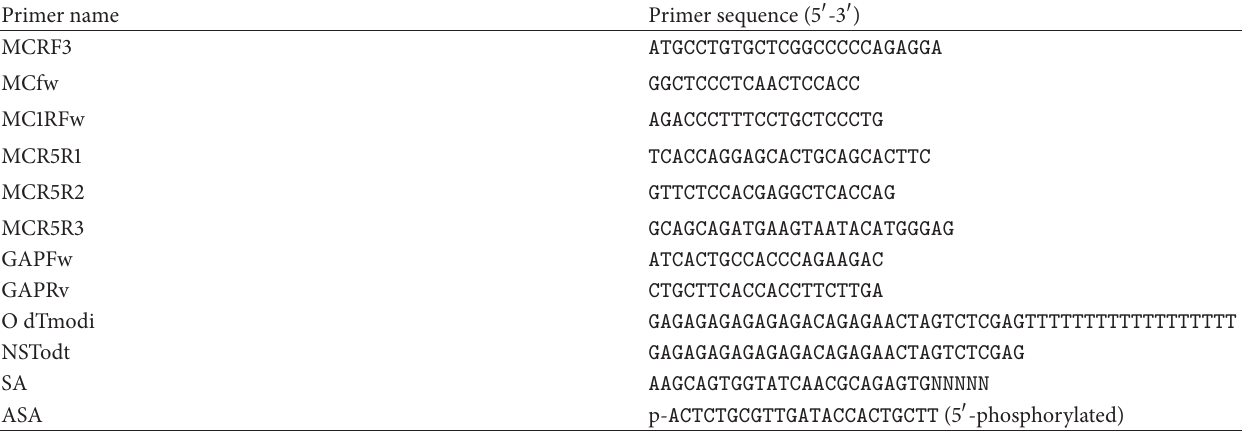
Table 1: Primer sequences used in coding sequence amplification, 5 󸀠 and 3 󸀠 RACE experiments, and expression analysis of MC1R